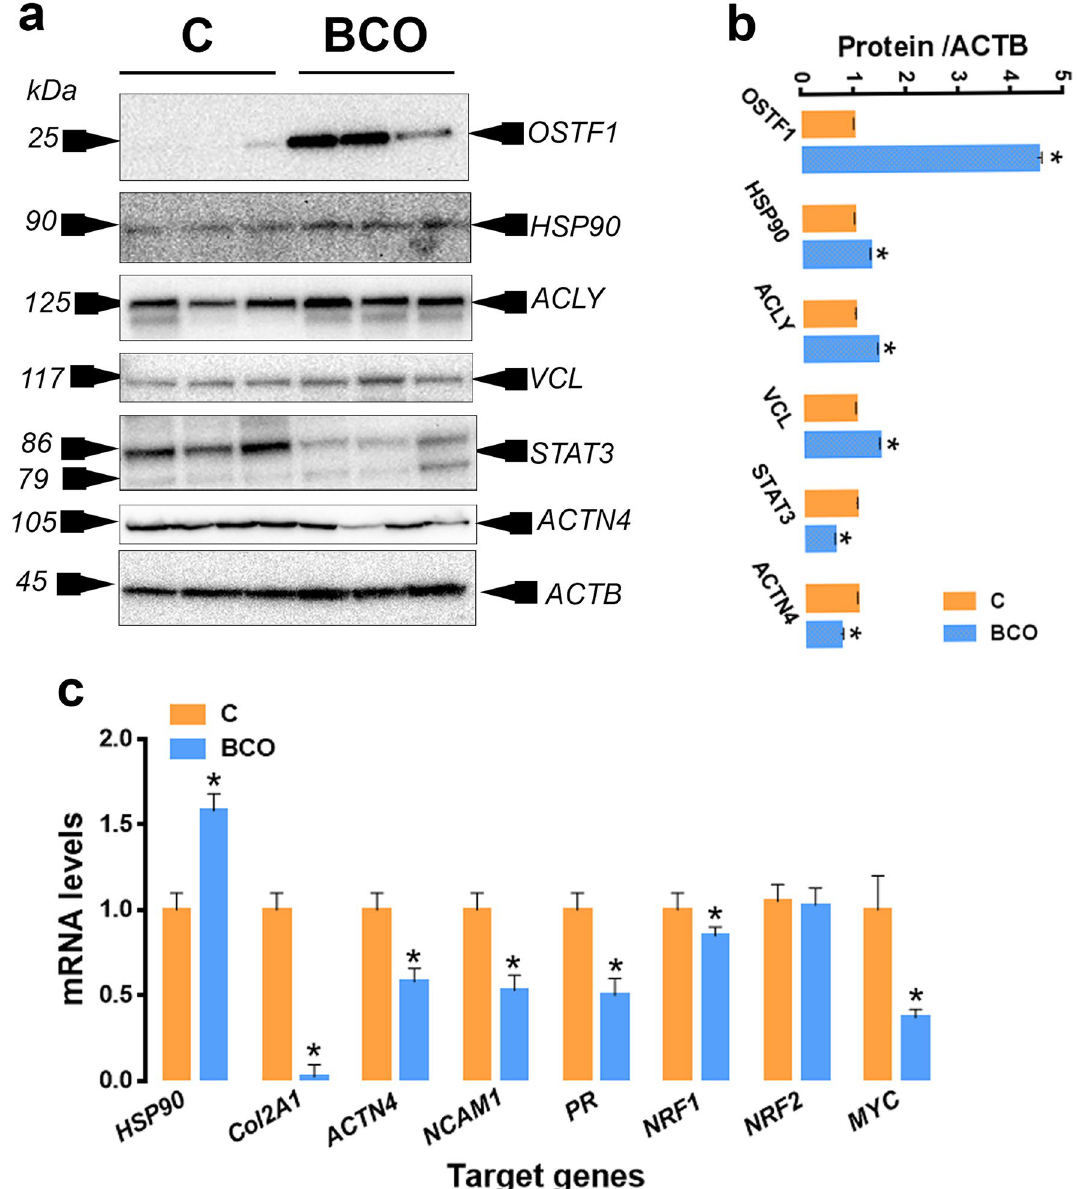
Figure 3. Validation of selected protein-encoding genes. Protein expression was determined by Western blot ( a , b ) and mRNA abundances were measured by qPCR and 2 -ΔΔCT method 23 . Data are mean ± SEM and * indicates a significant difference at P < 0.05. ACLY, ATP citrate lyase; ACTB, β actin; ACTN4, α-actinin 4; Col2A1, Collagen Type II Alpha 1 Chain; HSP90, heat shock protein 90; MYC, myelocytomatosis oncogene; NCAM1, Neural Cell Adhesion Molecule 1; NRF1/2, erythroid 2-related factor 1/2; OSTF1, Osteoclast-stimulating factor-1; STAT3, Signal Transducer And Activator Of Transcription 3; VCL,